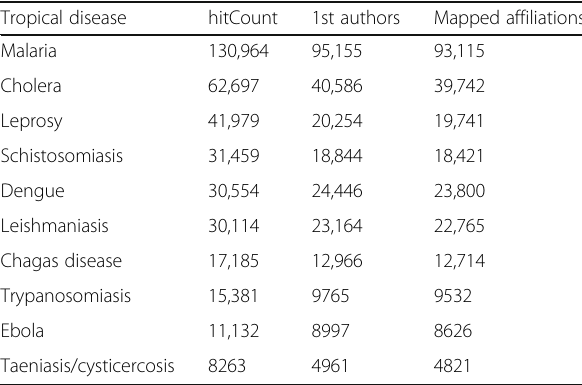
Table 1 The 10 most researched tropical diseases Tropical disease